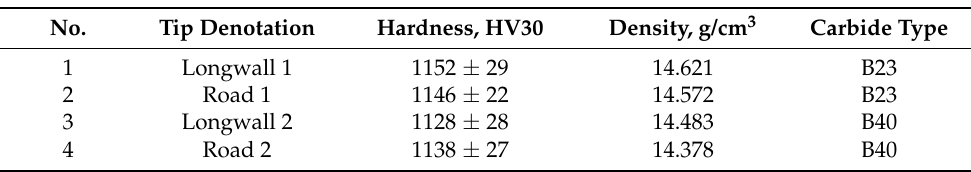
Table 1. Comparison results of the sintered carbide tips. No. Tip